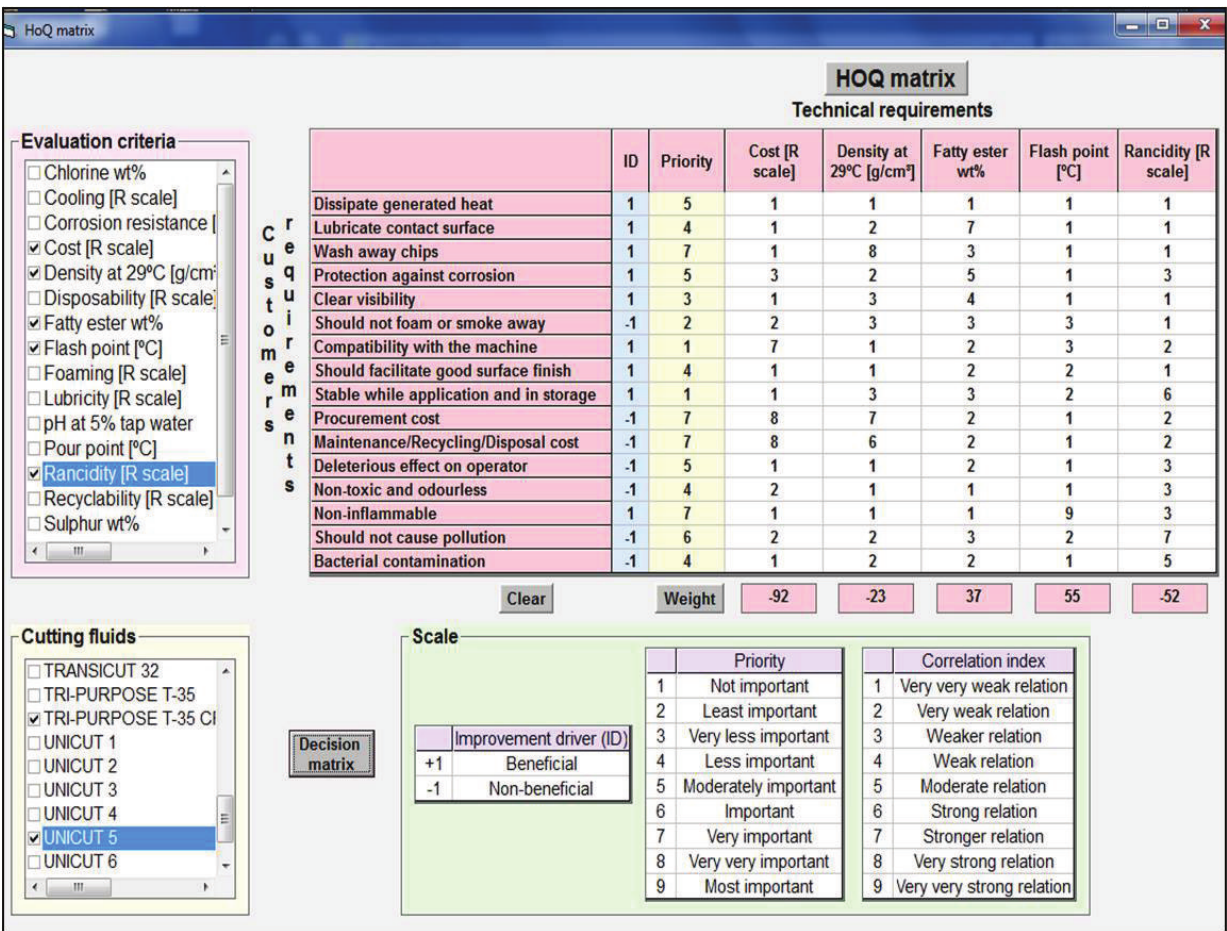
Figure 4: HOQ matrix for Example 1.